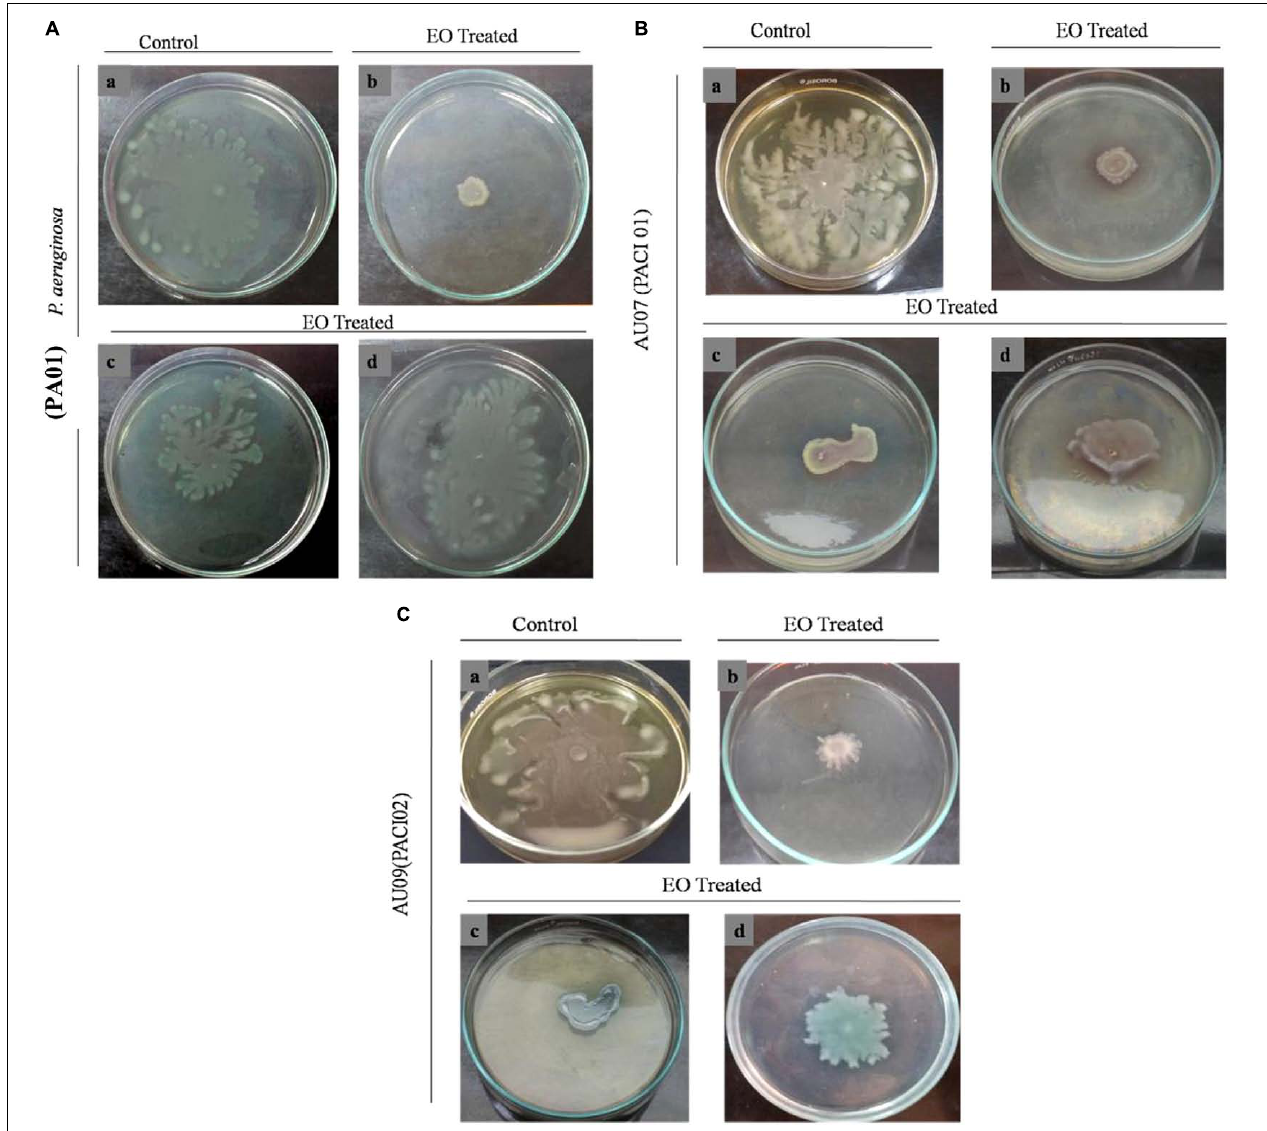
FIGURE 12 | Effect of EO on swarming motility of (A) P. aeruginosa in a concentration dependent manner. (a) Control, (b) EO Treated (1.25% v/v), (c) (2.5% v/v), (d) (5% v/v). (B) AU07-PACI-01 (a) Control, (b) EO Treated (1.8% v/v), (c) (3.5% v/v), (d) (7% v/v). (C) AU09-PACI-02 (a) Control, (b) EO Treated (1.8% v/v), (c) (3.5%v/v), (d) (7%